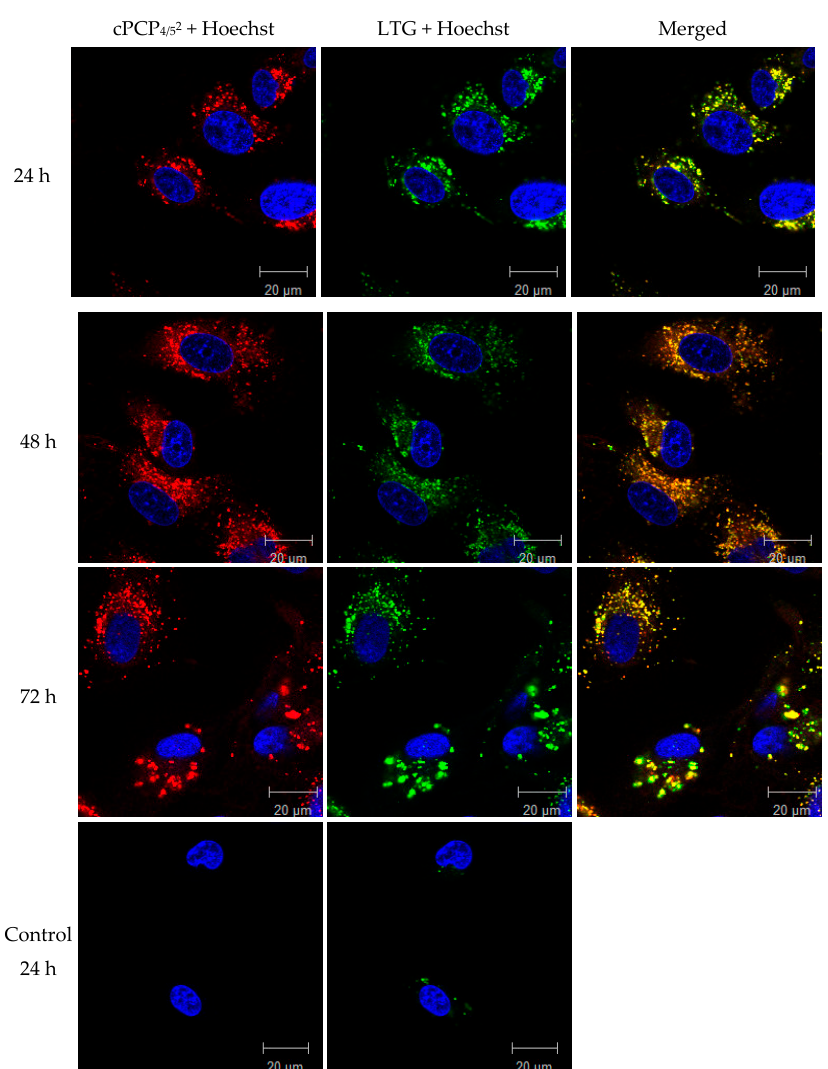
Figure 5. Confocal microscopy micrographs of HT1080 cells incubated with 30 μ M of cPCP 4/52 for 24, 48 and 72 h. Control cells are presented after 24 h incubation in the cell medium. DOX fluorescence is presented in red. Hoechst 33342 was used to stain the nuclei (blue) and LysoTracker ® Green (LTG) to label the lysosomes (green). Yellow color represents the merged signal between red and green channels meaning the co-localization of DOX with cell lysosomes. Magnification 63X, scale bar 20 µ